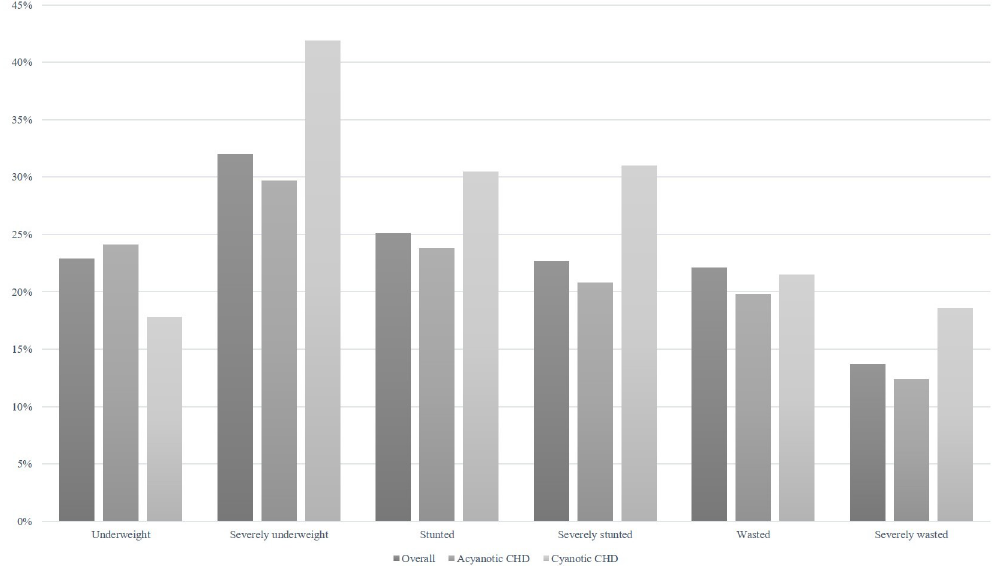
Fig 1. Incidence of undernutrition in children with CHD. Underweight, stunting and wasting were significantly associated with increased mortality with OR of 3.54 (95% CI: 1.62–7.74), p < 0.001; 3.31 (1.65–6.64), p < 0.001; and OR 1.64 (95% CI: 0.87–3.09), p = 0.129, respectively. In the multivariate analysis, delayed diagnosis of CHD, CHF, PH, presence of syndrome, low birth weight and being first child were independently associated with underweight (Table 2). The most common syndrome was Down syndrome.